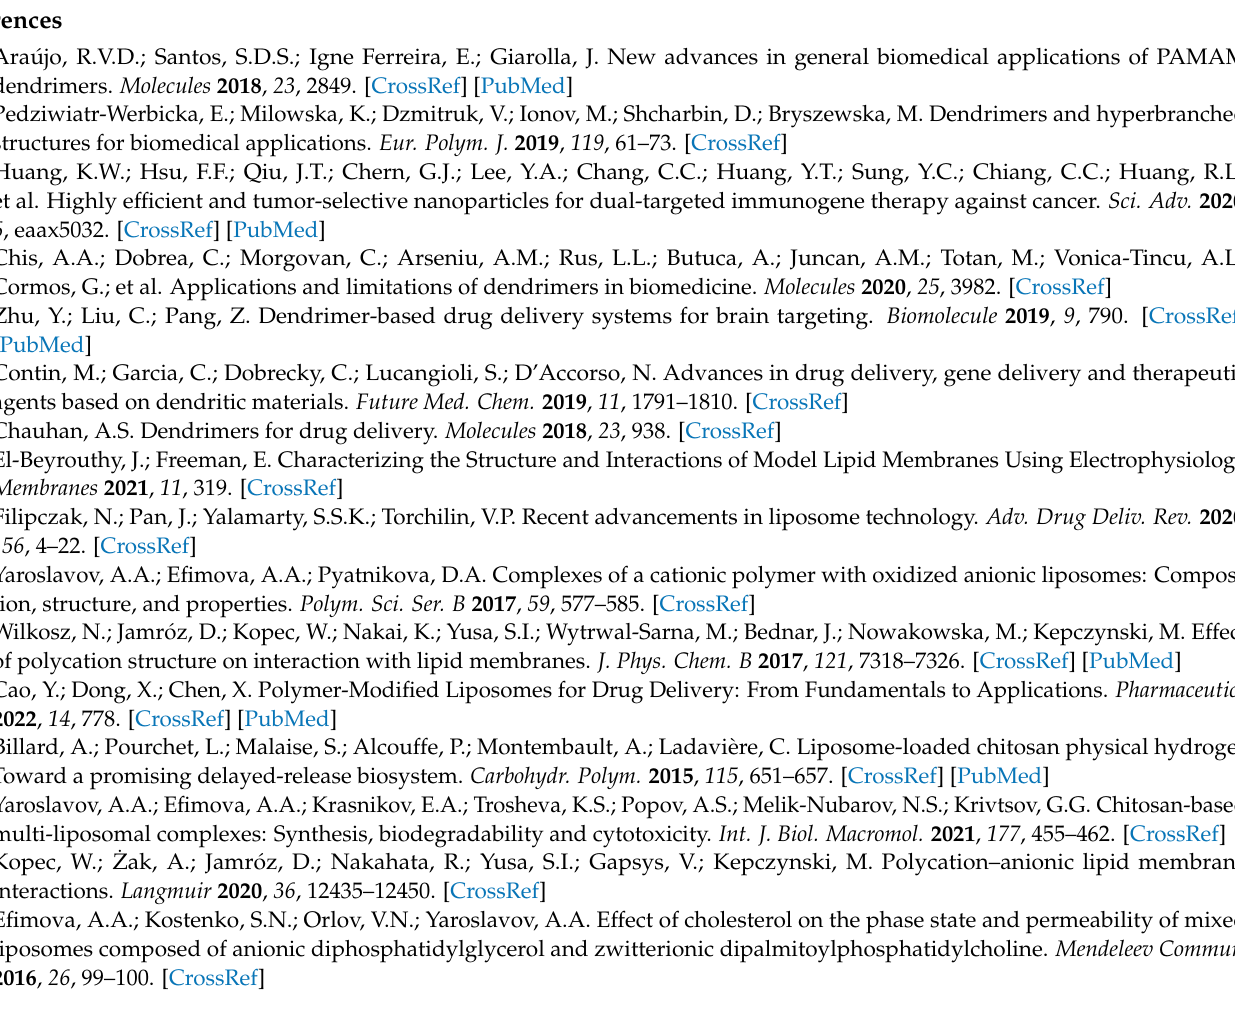
Figure S2: Examples of the experimental autocorrelation curves for dendrimer-liposome complexes for D 350+ (1), D 229+ (2), D 215+ (3) and D 16+ (4) with different ratio of the ionic groups [+]/[ − ], where [+] is the molar concentration of pyridinium groups of the dendrimer and [ − ] is the molar concentration of negatively charged cardiolipin headgroups. [+]/[ − ]= 2.5 (1), 2.7 (2), 0.1 (3), 1.4 (4). CL/Chol/DOPC liposomes, [CL] = 1.5 × 10 − 4 mol/L, total lipid concentration 1 mg/mL. 10 − 3 M phosphate buffer, pH